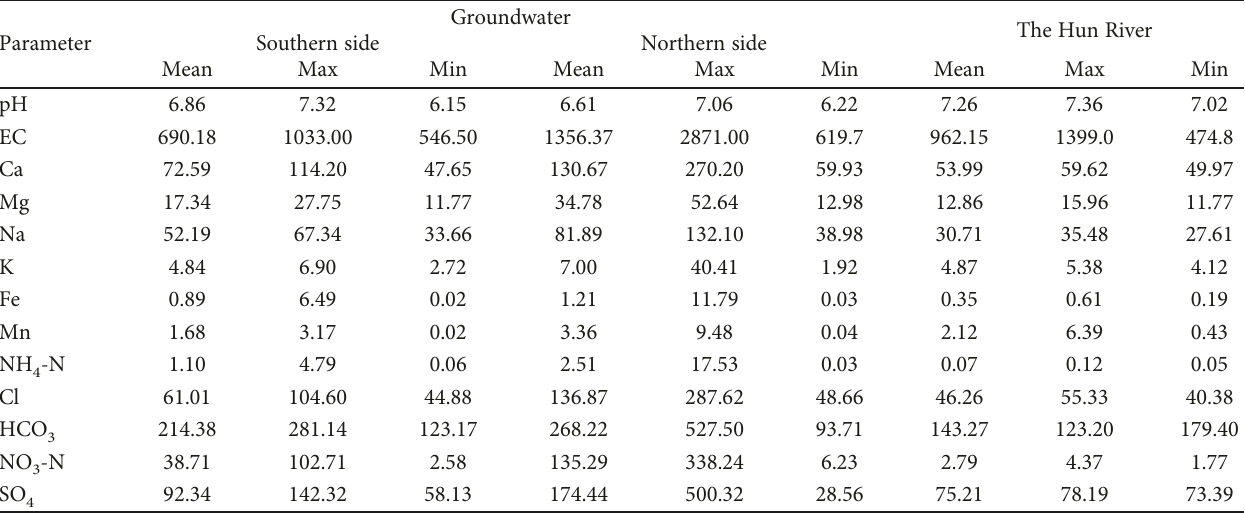
Table 3: Statistical summary of hydrochemical data in the Shenyang areas, June 2011. All units are in mg · L − 1 , except for electrical conductivity (EC, μ S · cm − 1